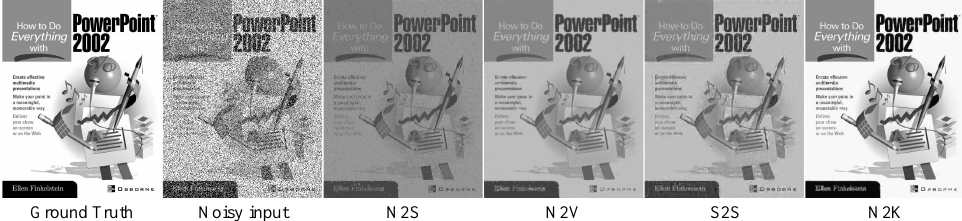
Figure 1. Denoising results on the image highly corrupted by non-zero mean salt-and-pepper noise. Note that the results of N2S, N2V, and S2S look much darker than the ground truth. Our proposed method (N2K) successfully removes noise without brightness